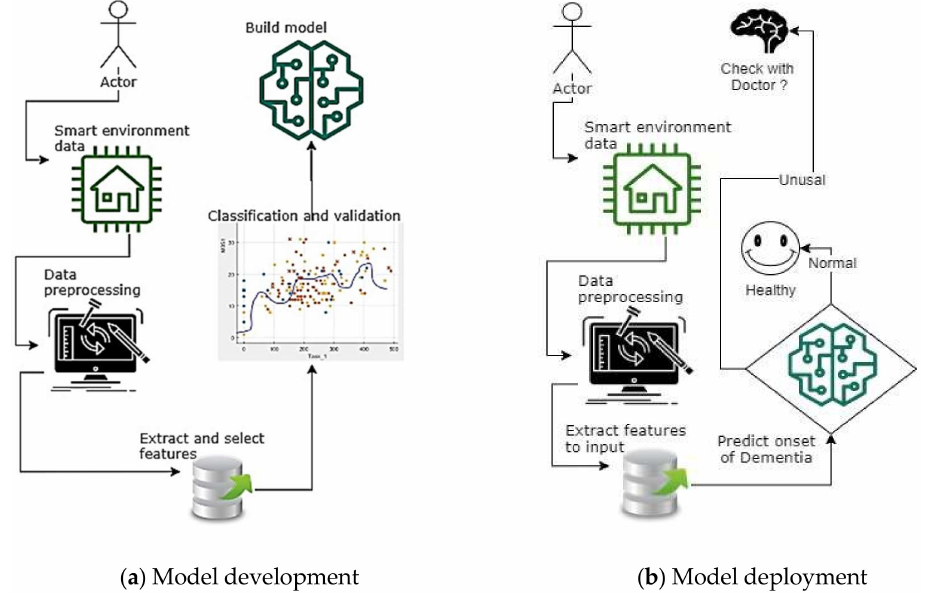
Figure 2. Flowchart of the system to identify the onset of